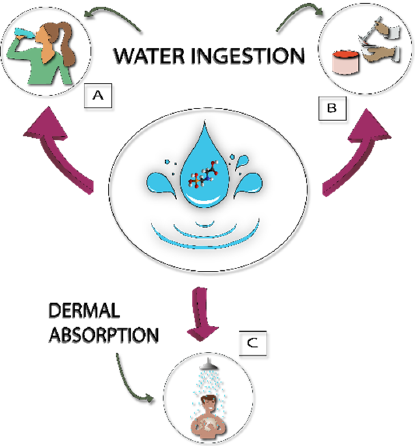
Figure 3. Social activities that affect human exposure to glyphosate from polluted water: ( A ) drinking water; ( B ) food preparation; and ( C ) showering.